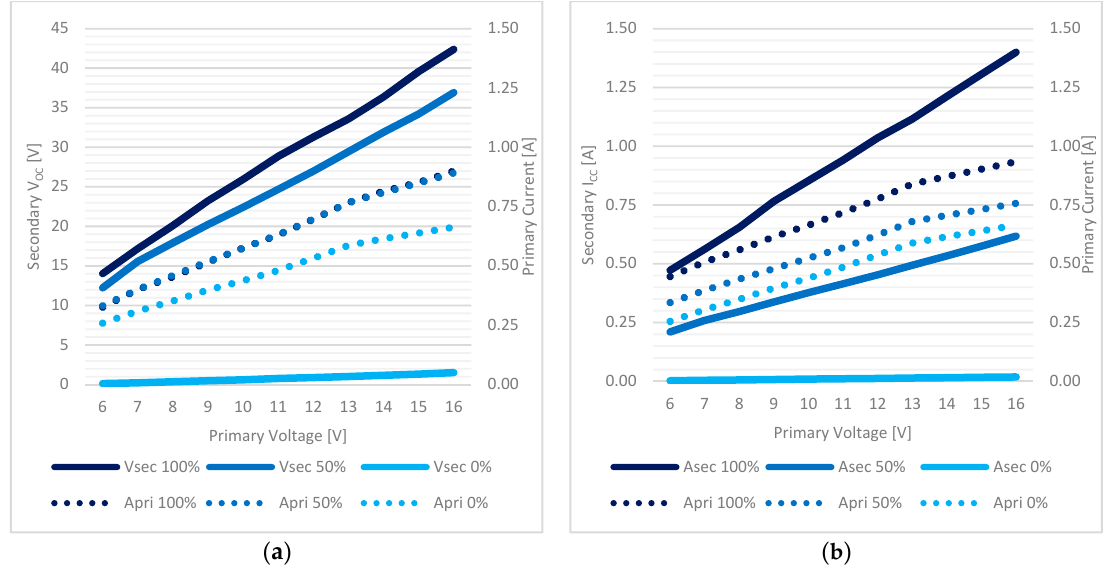
Figure 18. WPT analysis in the embedded system: ( a ) V OC of the WPT system, ( b ) I CC .